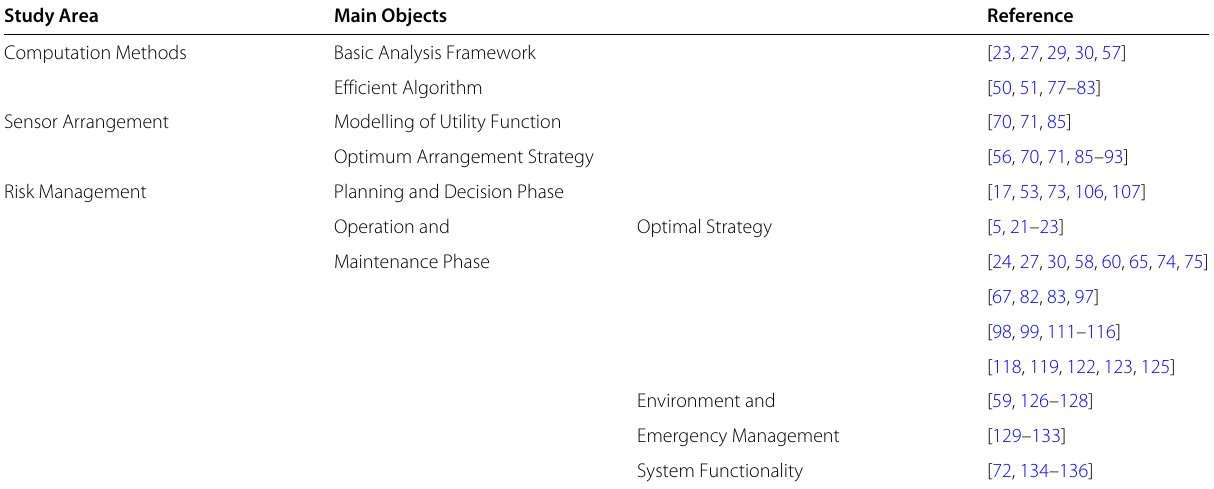
Table 1 An overview of the reviewed studies in the present work Study